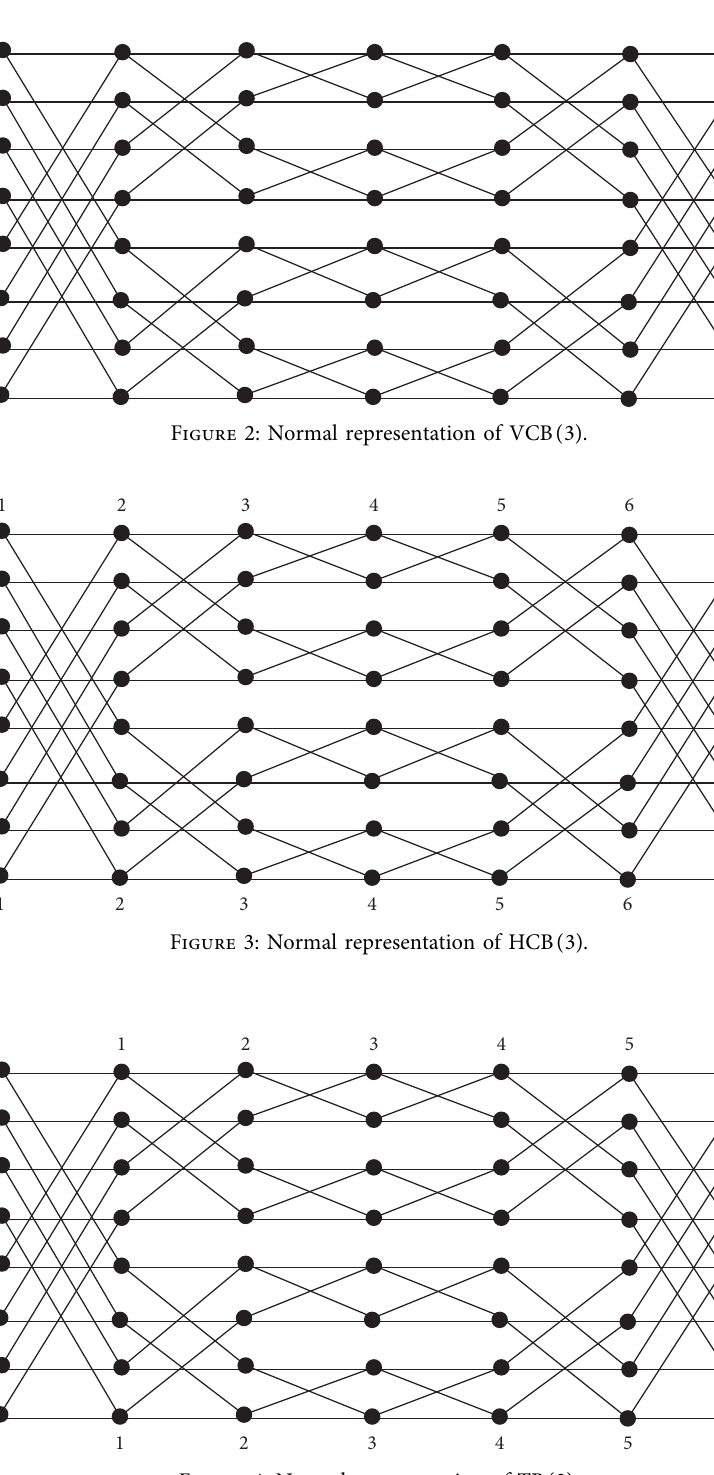
Figure 4: Normal representation of TB ( 3 )